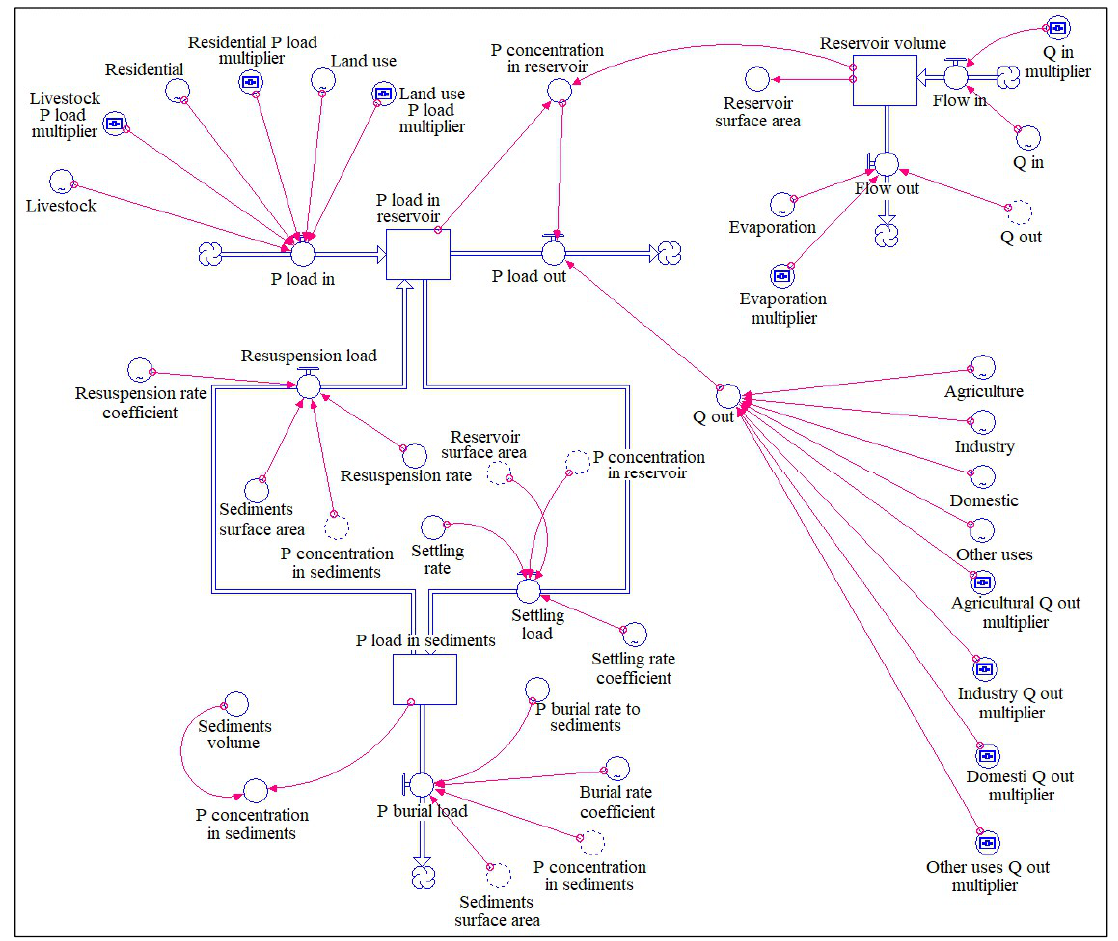
Figure 7. The SD model of the Mahabad Dam reservoir.